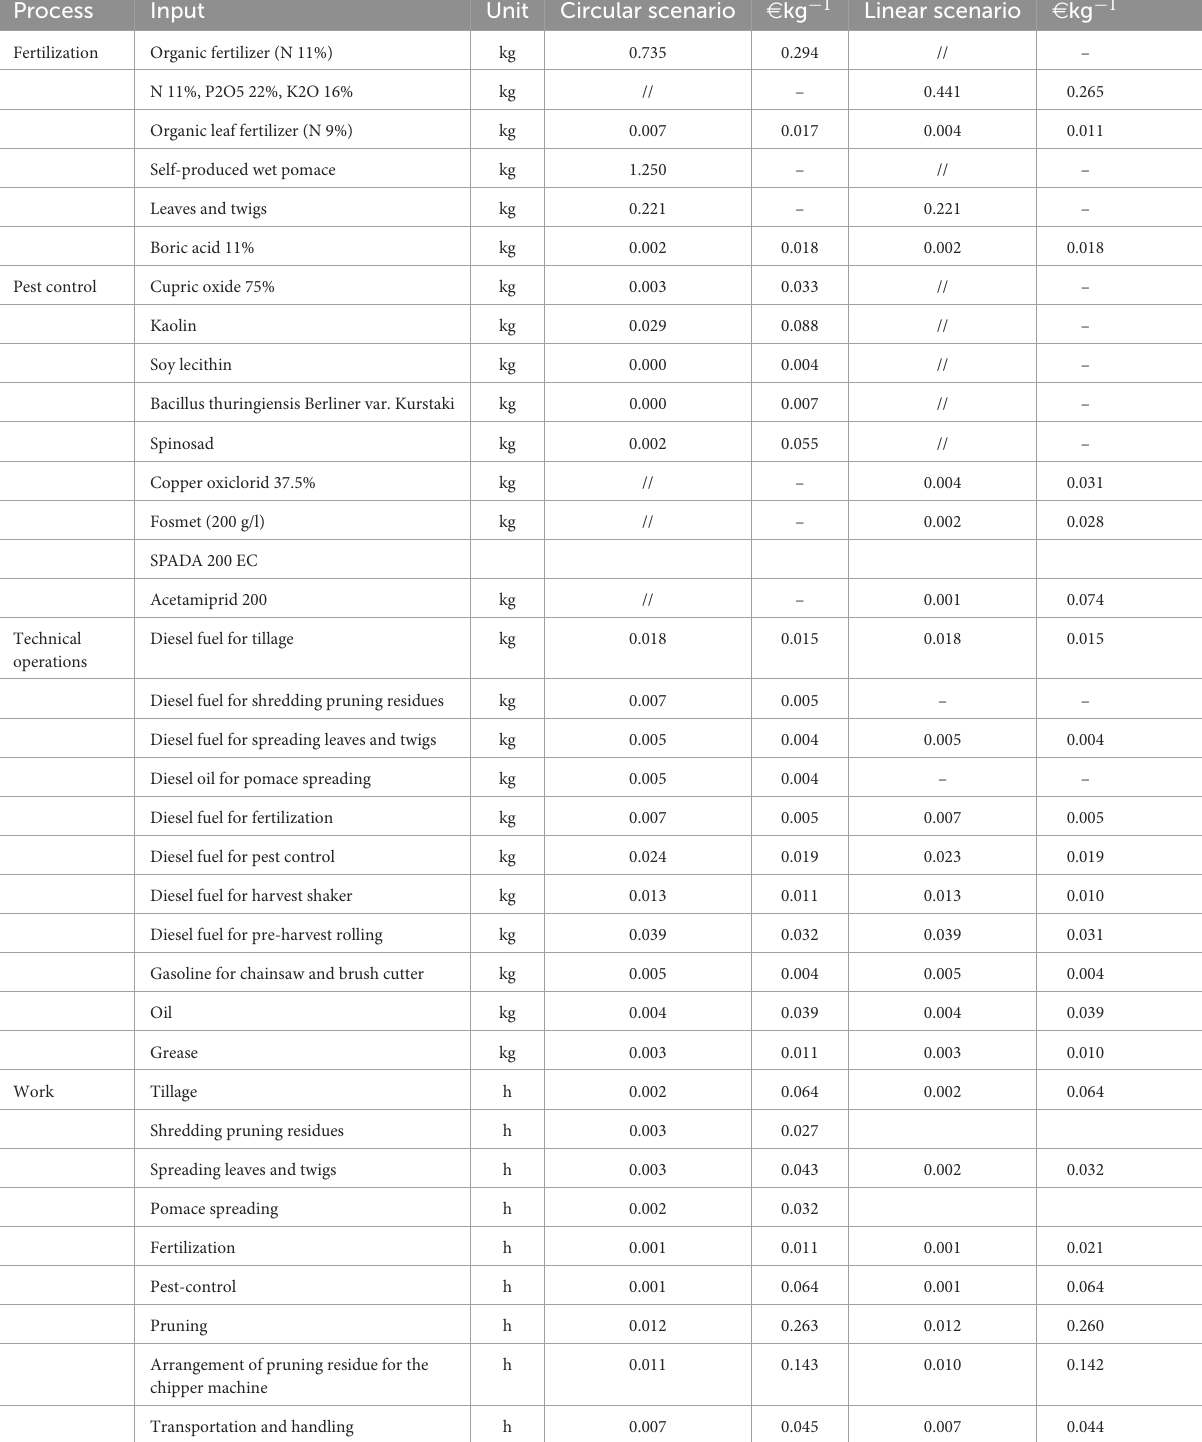
TABLE 1 Simplified environmental and economic life cycle